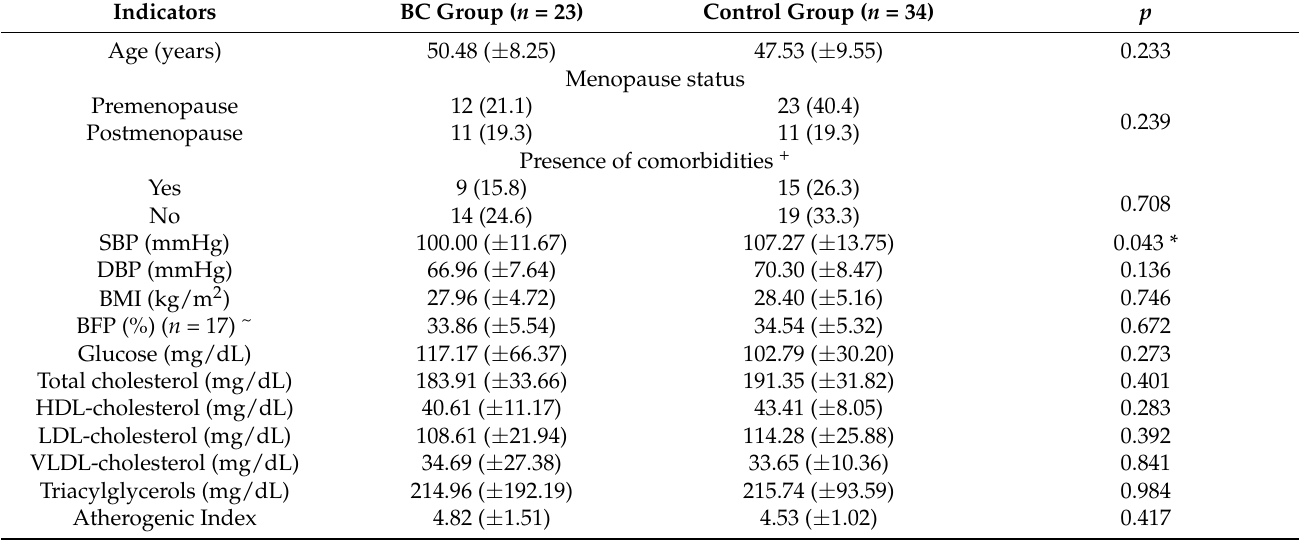
Table 3. Descriptive characteristics of the participants by study group ( n = 57).